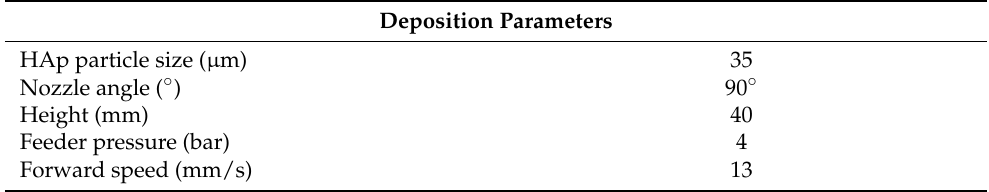
Table 1. Deposition Parameters used in CB coating process.